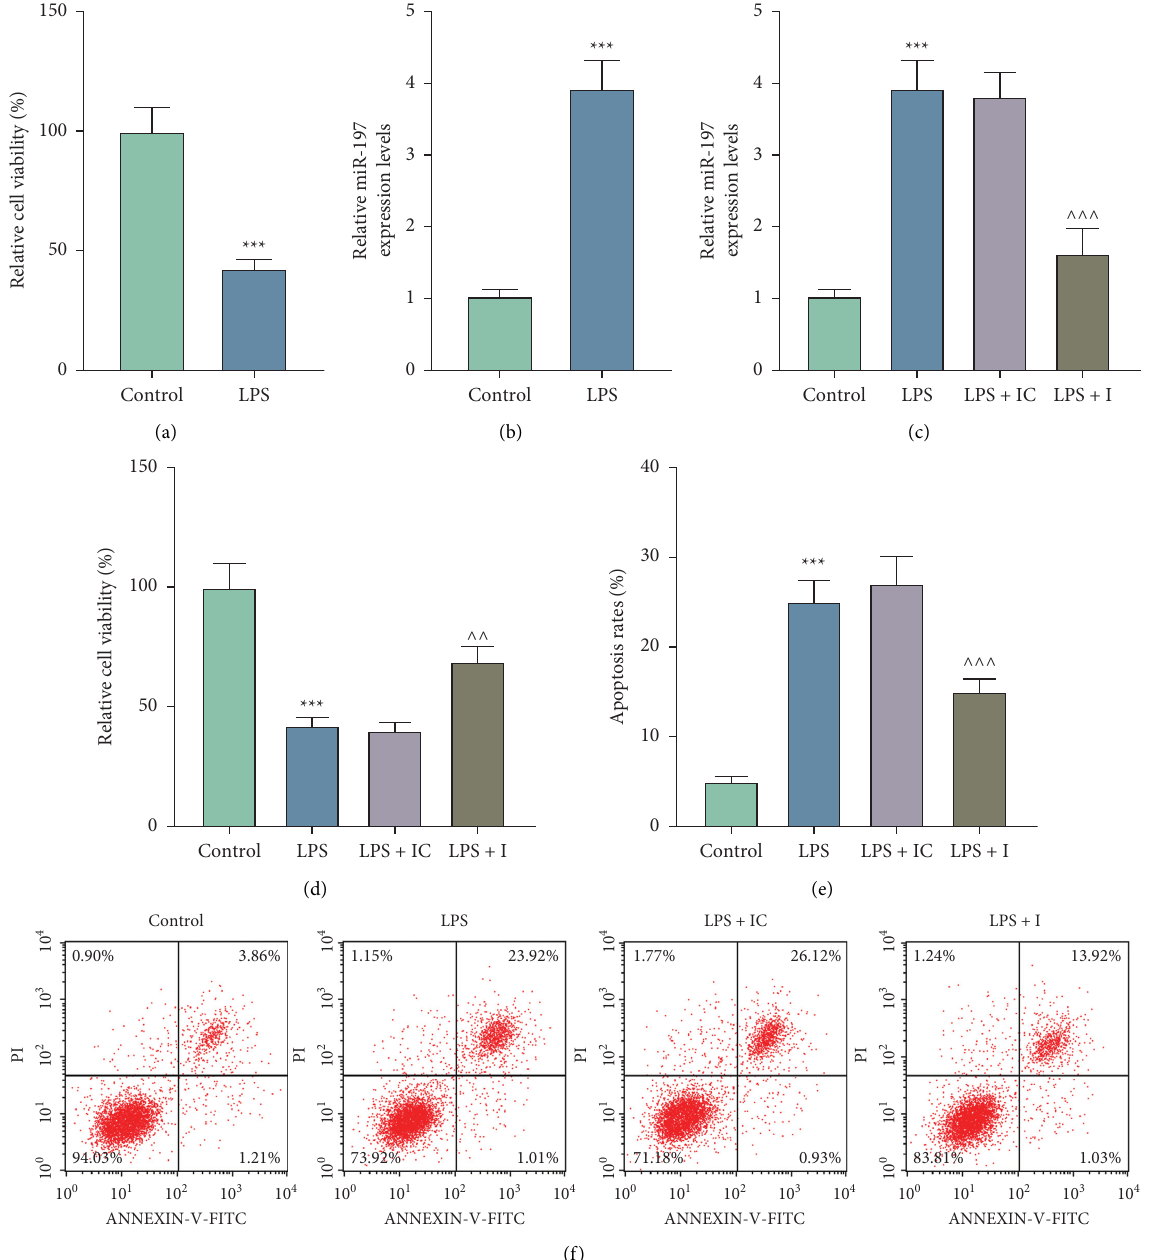
Figure 1: Effects of miR-197 on the viability and apoptosis of LPS-induced H9c2 cells. (a) The effect of LPS on H9c2 cell viability was detected by the CCK-8 assay. (b) The expression level of miR-197 in LPS-induced H9c2 cells was examined by qRT-PCR. U6 was used as the internal control. (c) To affirm the effect of the miR-197 inhibitor, qRT-PCR was applied to detect miR-197 expression level. U6 was used as the internal control. (d) The CCK-8 assay was conducted to examine the viability of LPS-induced H9c2 cells transfected with or without the miR-197 inhibitor. (e, f) Flow cytometry was performed to demonstrate the apoptosis of cells after LPS treatment or transfection. The experiments were repeated in triplicate. ∗∗∗ p < 0 . 001 vs. control; ∧∧ p < 0 . 01; ∧∧∧ p < 0 . 001 vs. LPS +IC. LPS, lipopolysaccharide; CCK-8,